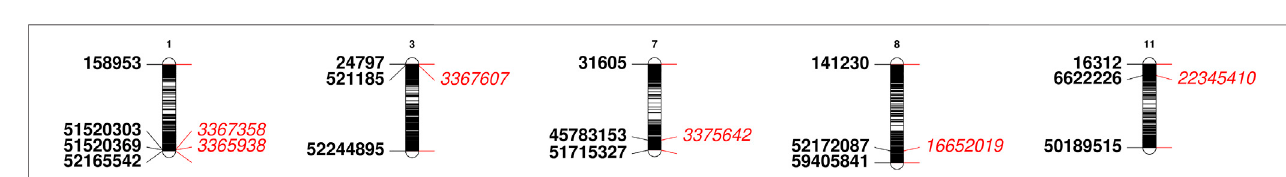
FIGURE 5 | Physical map of identi fi ed DArTseq markers having association with seed Mg contents in Turkish common bean germplasm.